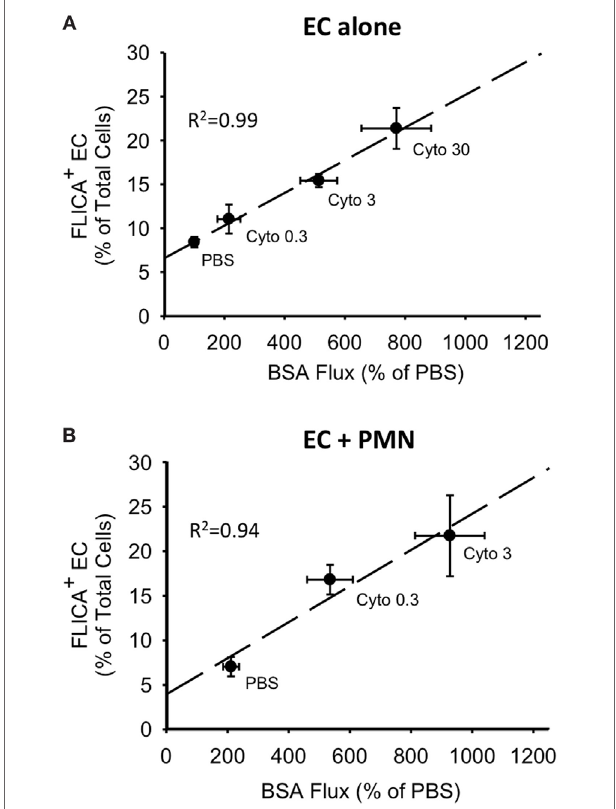
FigUre 6 | Correlations between cytomix-induced increases in PMVEC caspase activity and trans-PMVEC macromolecular flux in isolated PMVEC and in PMN–PMVEC cocultures. Cytomix dose-dependently increased PMVEC macromolecular permeability [Evans blue-bovine serum albumin (BSA); x -axis], which was highly correlated with caspase activation (FLICA + cells; y -axis) in PMVEC cultured alone (a) and in coculture with PMN (B) . Note: given the greater sensitivity of PMN–PMVEC cocultures (B) to cytomix stimulation, only low (0.3 ng/mL) and medium (3 ng/mL) doses of cytomix were used, compared to high dose (30 ng/mL) cytomix in PMVEC alone (a) . n = 4–6 for each